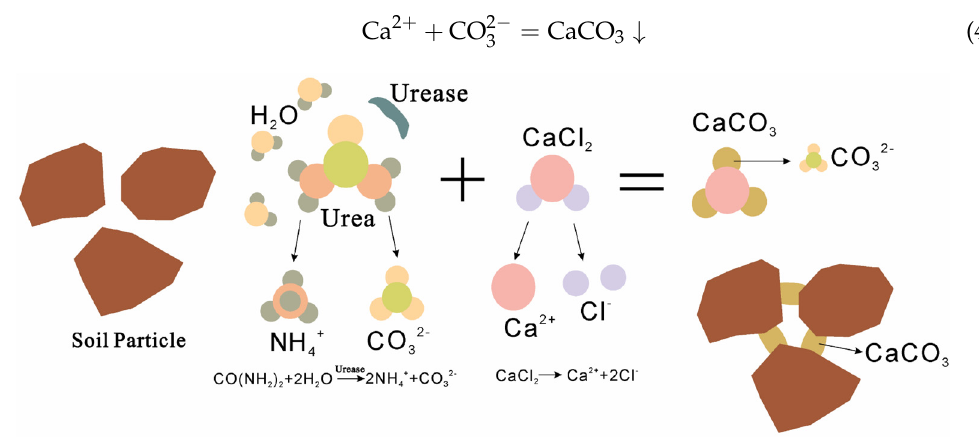
Figure 1. Summary of the carbonate precipitation process through urea hydrolysis.